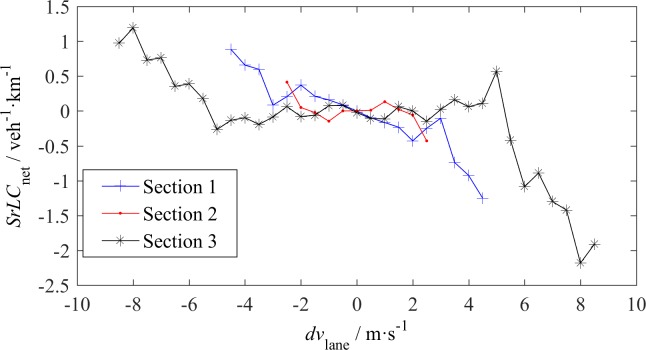
Net inflow LC rate—dvlane relationship.